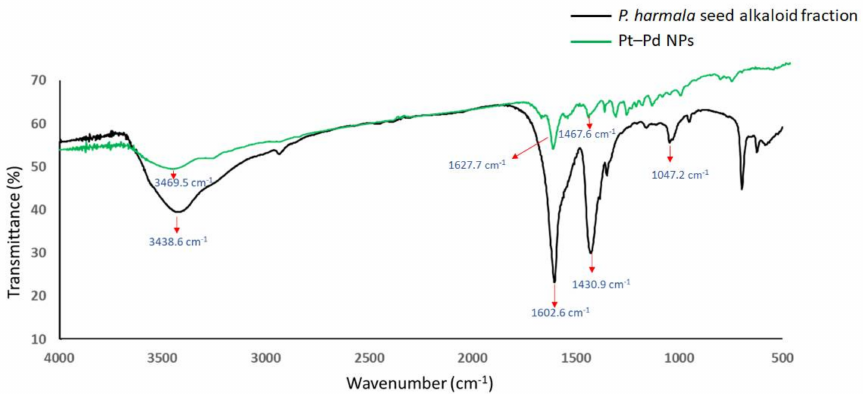
Figure 4. Fourier transform infrared (FTIR) spectra of P. harmala seed alkaloid fraction and Pt–Pd